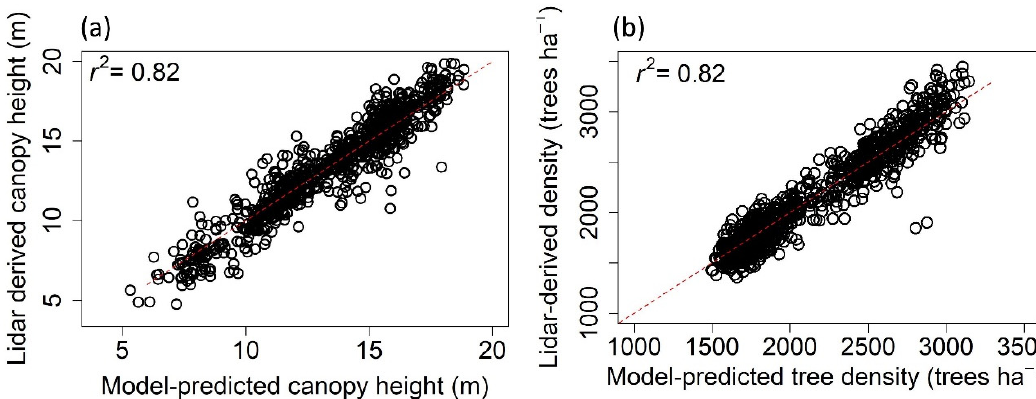
Figure 5. Model-predicted intact canopy height versus LiDAR CHM ( a ), and model predicted intact tree density versus LiDAR-detected tree density ( b ).